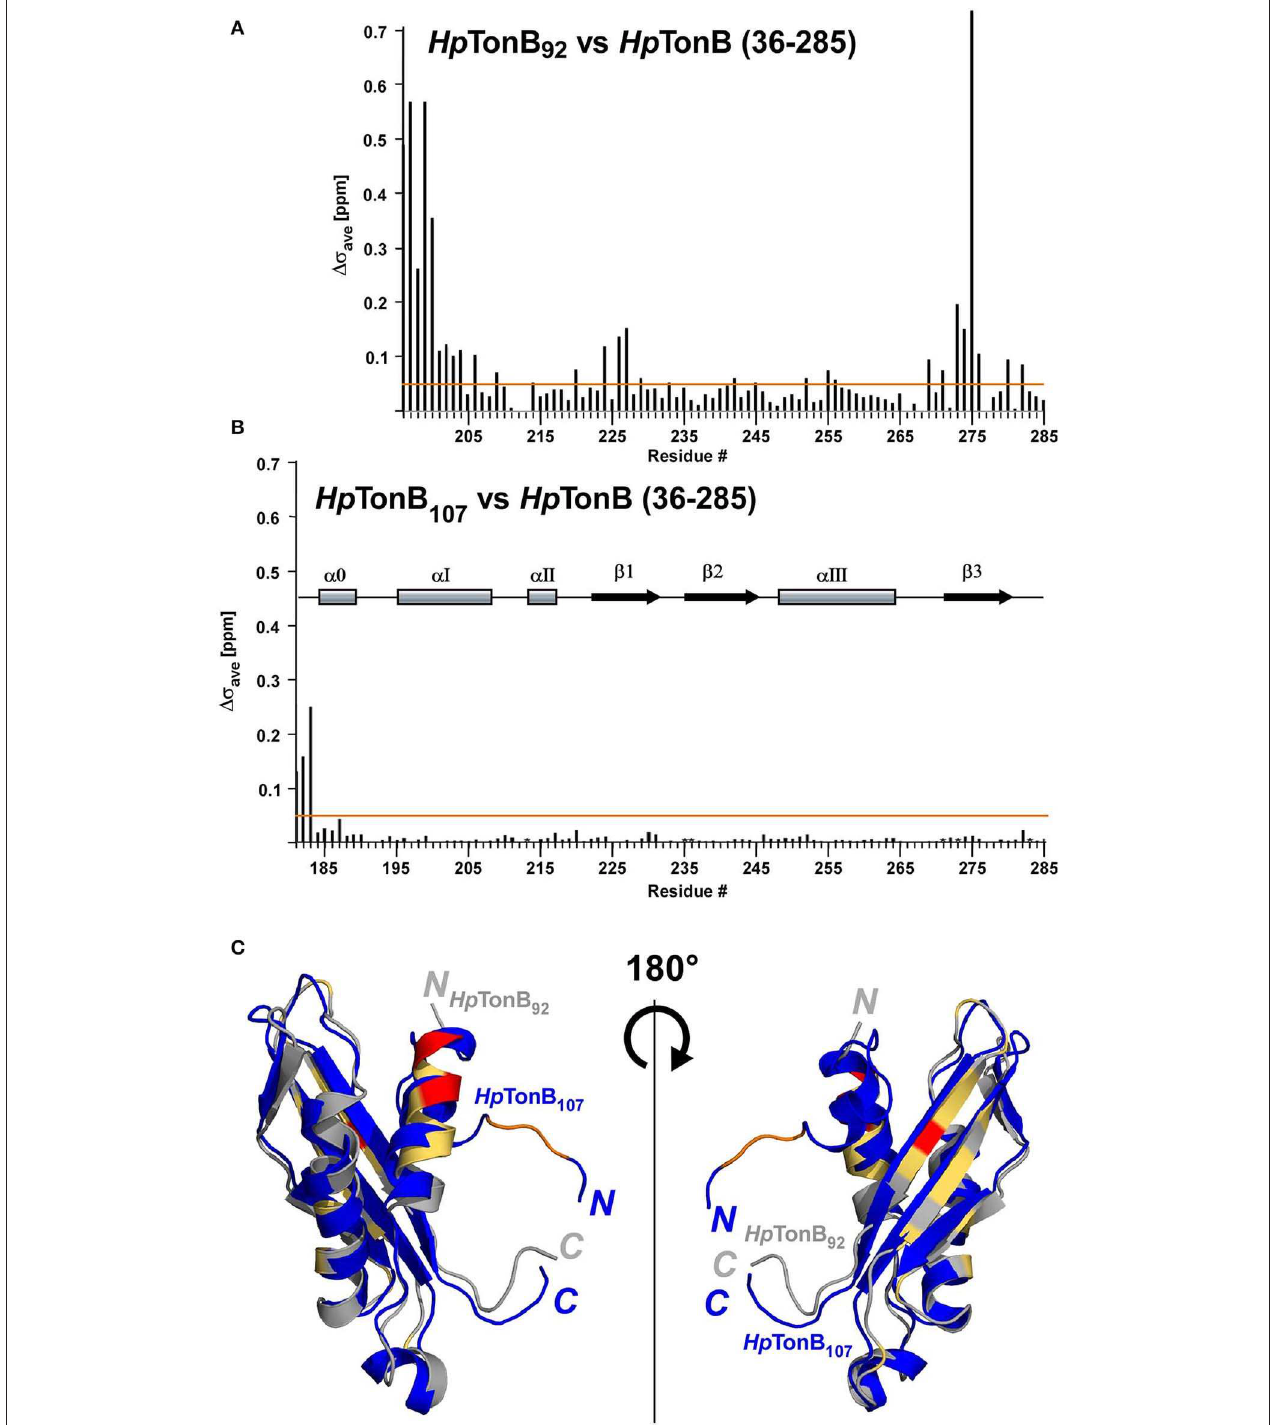
FIGURE 5 | The effects on chemical shifts by dissection of the full-length of Hp TonB. (A) Chemical shift differences ( 1 σ ave ) between Hp TonB 92 and Hp TonB (36–285). (B) Chemical shift difference ( 1 σ ave ) between Hp TonB 107 and Hp TonB (36–285). The chemical shift difference ( 1 σ ave ) was derived from the equation: 1 σ ave = (( 1 δ H) 2 + (0.154 × 1 δ N) 2 ) 1 / 2 . Orange lines indicate 1 σ ave = 0.05 ppm. The locations of the secondary structural elements of Hp TonB 107 are indicated above the bar graph. (C) Ribbon drawings of the superimposition of the two structures of Hp TonB 92 and Hp TonB 107 shown in gray and blue, respectively. Residues with > 0.3 ppm for 1 σ ave are colored in red. Residues above the threshold of 1 σ av = 0.05 ppm are colored in orange for Hp TonB 107 and light orange for Hp TonB 92 . The N- and C-termini are indicated by N and C , respectively.